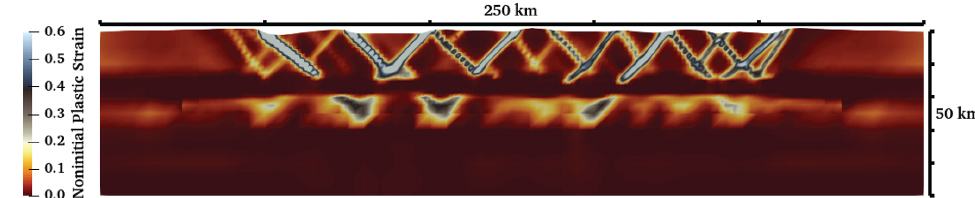
Figure B4. Cross section at y = 300km, showing the non-initial plastic strain attribute through 10Myr of the model run. This section crosses the centre of the weak domain. See Fig. 4b for a 10Myr snapshot. Screenshot taken at 10Myr.